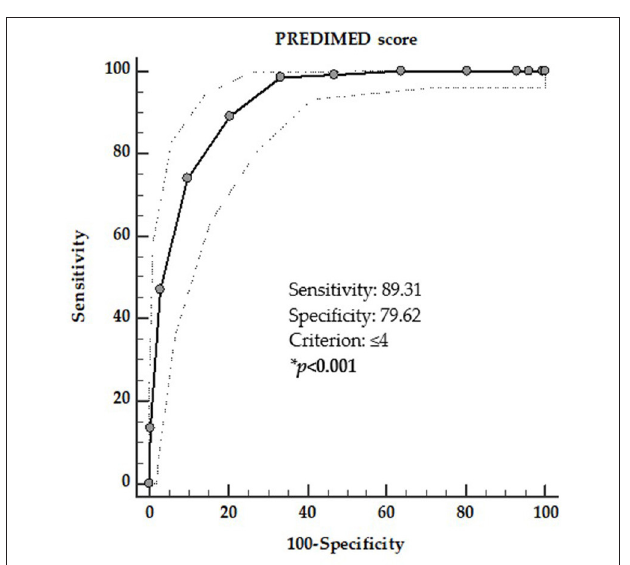
FIGURE 3 | ROC for predictive values of PREDIMED score in detecting the presence of TIR4/TIR5 cytology category. A PREDIMED score ≤ 4 ( p = 0.001,